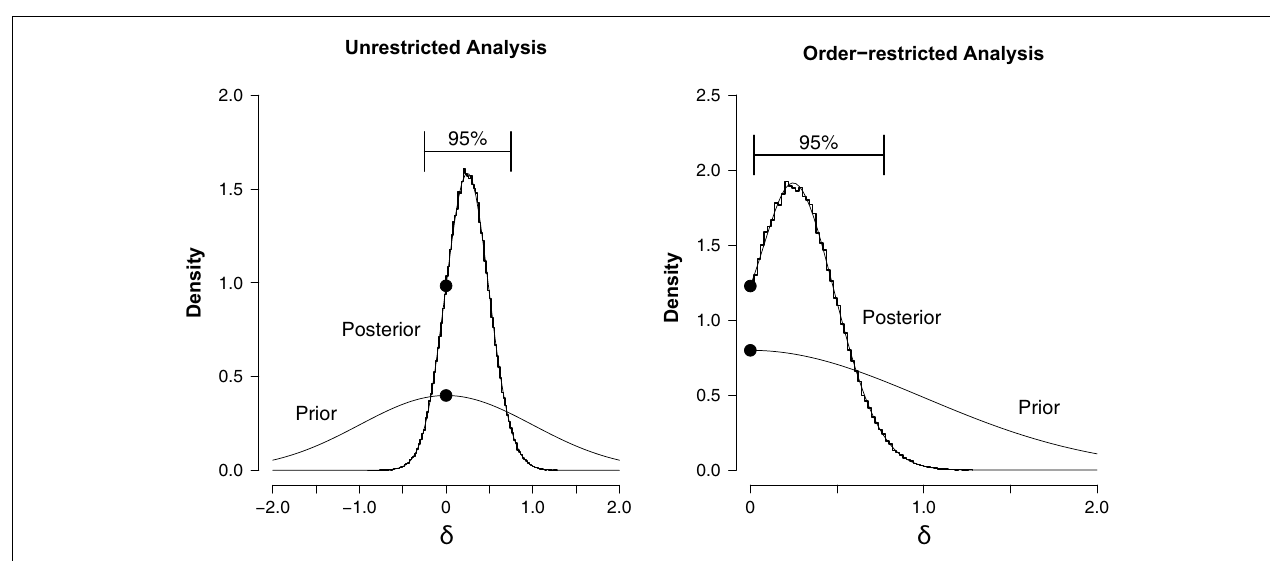
logspline non-parametric density estimate (thin line).The 95% confidence interval for the posterior extends from − 0.247 to 0.750 for the unrestricted analysis (left panel), and from 0.020 to 0.770 for the order-restricted analysis (right panel).The black dots mark the height of the prior and the posterior at the point of interest δ =